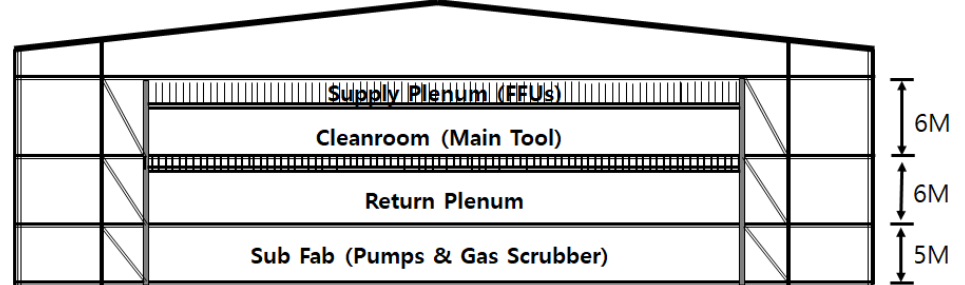
Figure 1. Semiconductor FAB structural